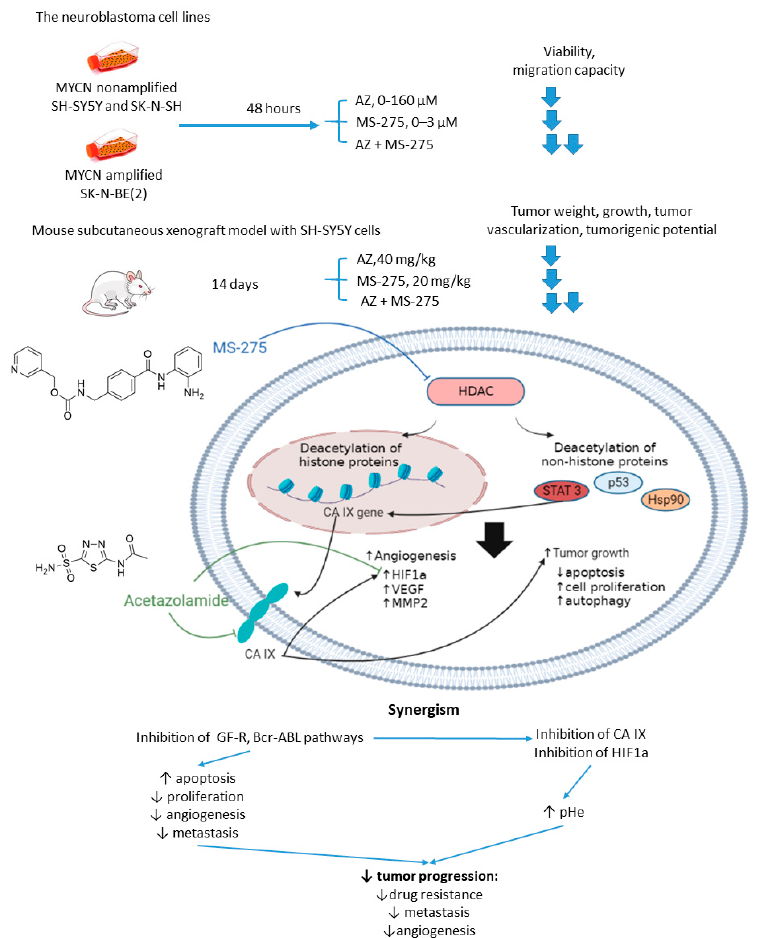
Figure 7. Graphical outline of the study on AZ+MS-275 combination reported by Mokharti et al., and summary on the hypothesized molecular interactions resulting in synergistic action of the drugs [60].